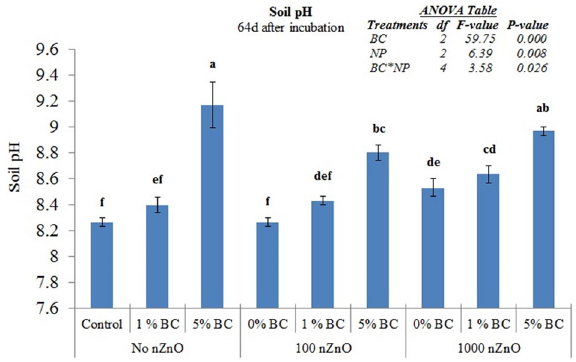
Figure 1. Soil pH as affected by zinc oxide (nZnO) and rice-straw derived biochar after 64d of incubation. Different small letters on top of bars represent post-hoc HSD difference at 95% confidence intervals. Error bars represent standard errors of means (n =